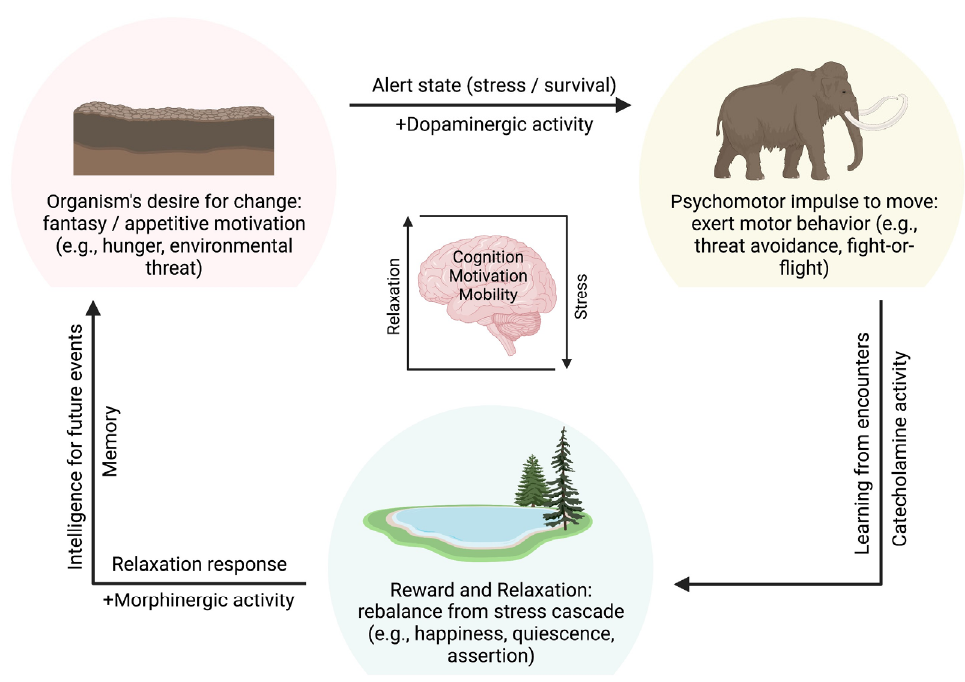
Figure 3. Functional significance of the three motivation systems from an evolutionary biological perspective. Appetite/approach, avoidance/aversion, and assertion/quiescence follow in a motiva- tional order that connects cognition with mobility: Mobile animals evolved an “appetite” for change, followed by a psychomotor impulse to move and behaviorally implement the actual change, which also required the ability to successfully overcome challenges along the way. The ability to recover from this stress was critical, also learning from its “adventures” for future encounters, eventually terminating this neurobiological sequence (motivational “circle”) by returning to normal and being “happy” (references: see text).